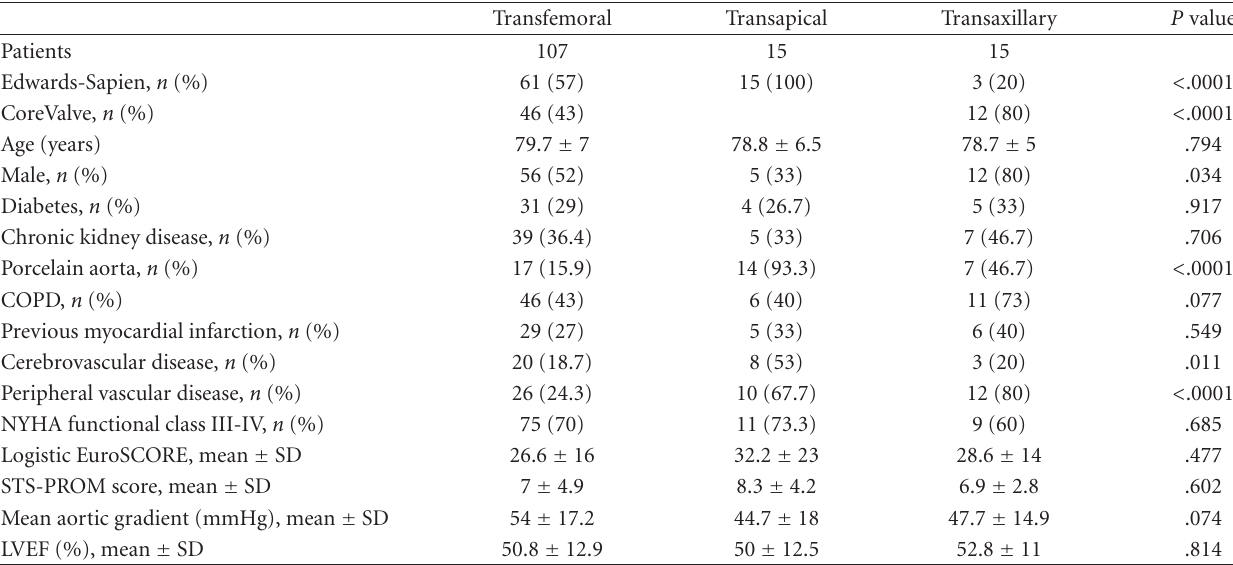
Table 1: Clinical characteristics of patients presenting for transcatheter aortic valve implantation.